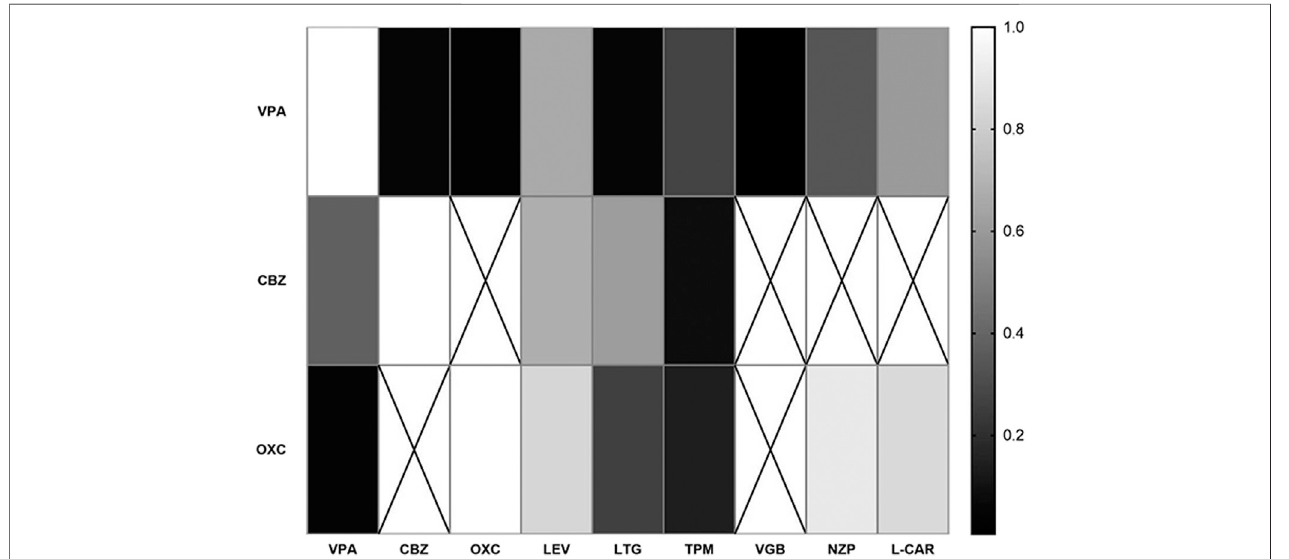
FIGURE 5 | Correlations of certain combinations with single agent of VPA, CBZ and